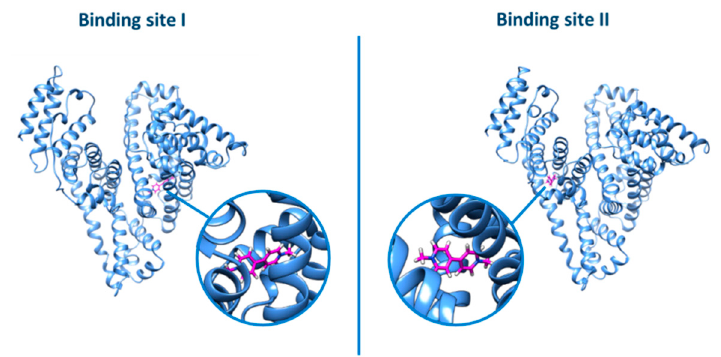
Figure 11. Docking of PQ in binding sites I or II of BSA.